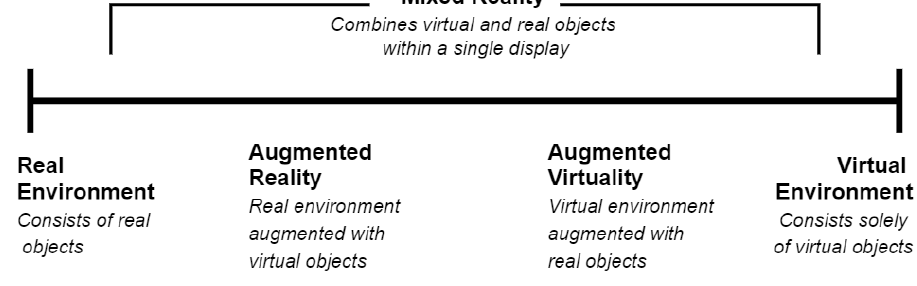
Figure 1. Milgram’s Continuum about Physical reality, Augmented Reality, Augmented Virtuality and Virtual Reality